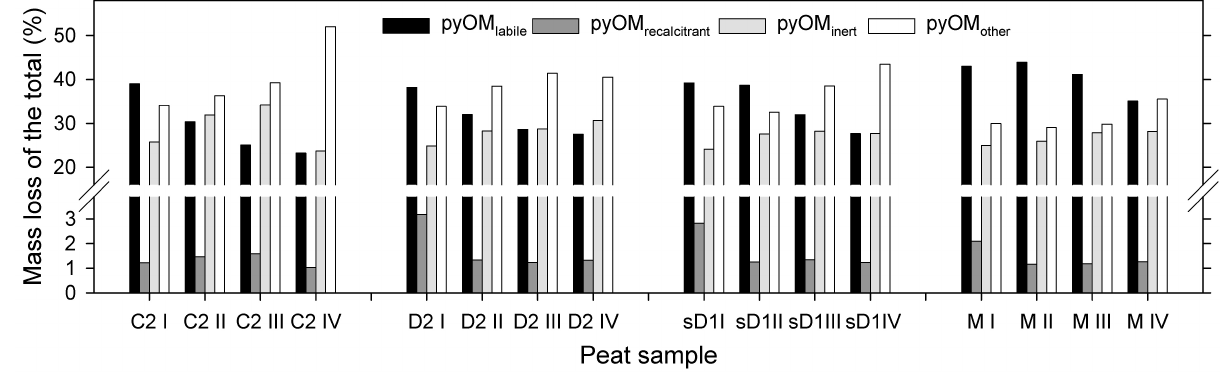
Fig. 2. Percentage of mass loss during thermogravimetry analyses ( n =2) over three temperature intervals corresponding to labile carbon (pyOM labile : 205–360 ◦ C), recalcitrant carbon (pyOM recalcitrant : 365–480 ◦ C) and inert carbon (pyOM inert : 850 ◦ C+oxygen) with respect to total pyrolyzable organic matter. Mass loss which is not explained by these three temperature intervals is expressed by pyOM other . Peat was obtained from 4 different sampling sites in an acidic fen along a hydrological gradient (from the middle to the south C2 → D2 → sD1 → M) over 4 depths (I: 0–10cm, II: 10–20cm, III: 20–30cm and IV: